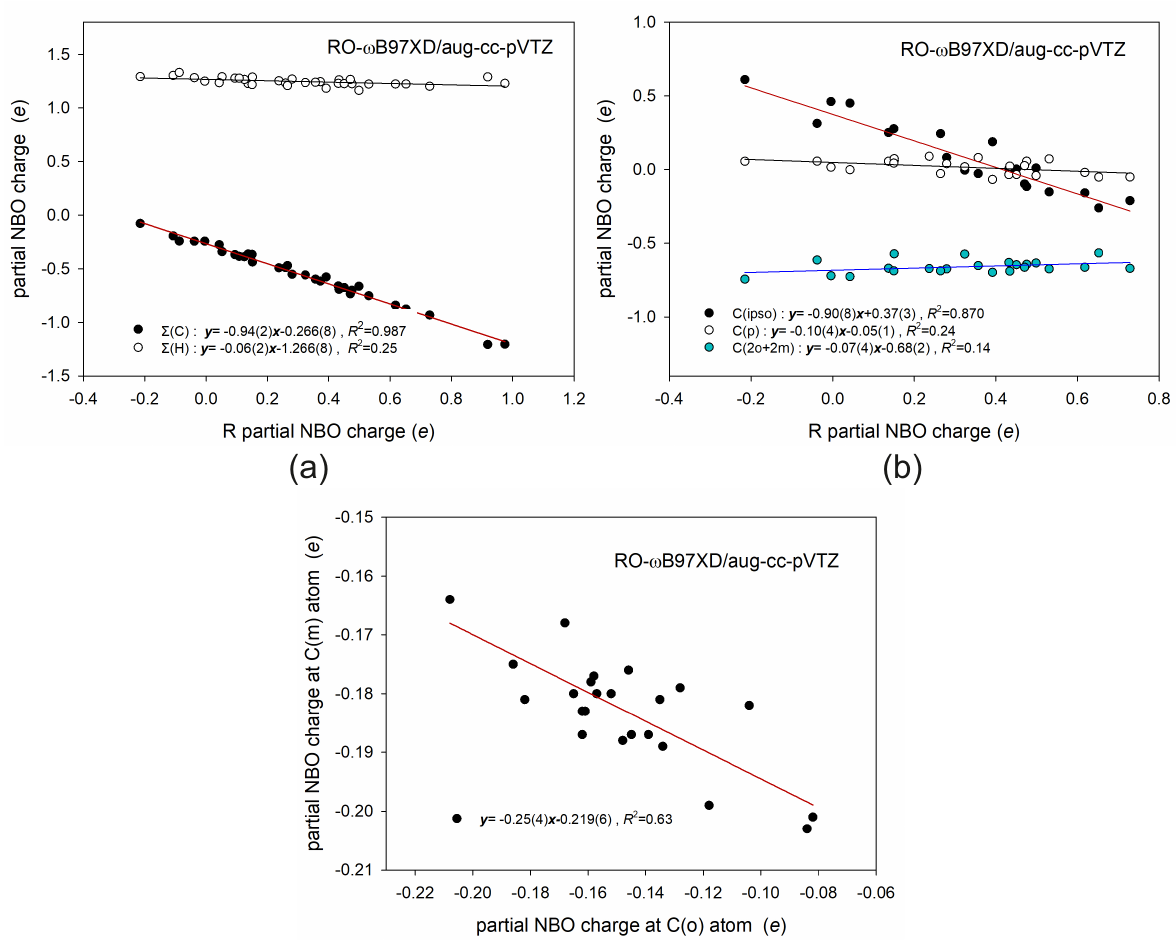
Figure 4. ( a ) Linear changes in the sum of the partial NBO charges at the ring C atoms, Σ (C), and lack of similar changes in the sum of charges at the ring H atoms, Σ (H), in the monosubstituted benzene cation radicals with the change in the charge at all R substituent atoms. ( b ) Linear changes in the partial NBO charge at the C(ipso) atom and lack of similar changes at the C(p), or sum of the ortho and meta C atoms, with the change in the charge at the R substituent. ( c ) Weak linear correlation between the partial charge at C(m) and C(o) atoms. All atypical systems (forms (II) and (e)) were omitted. Calculations were performed using the RO-DFT